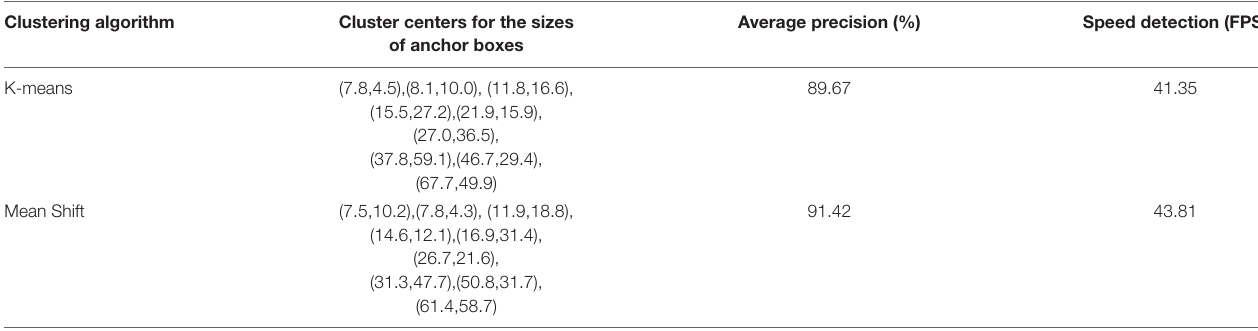
TABLE 1 | Comparison of the average detection precision and FPS between YOLO trained on K-means and YOLO trained on Mean Shift on the same manually annotated ITC dataset (all trained on the overall training samples of the three study sites). Clustering algorithm Cluster centers for the sizes of anchor